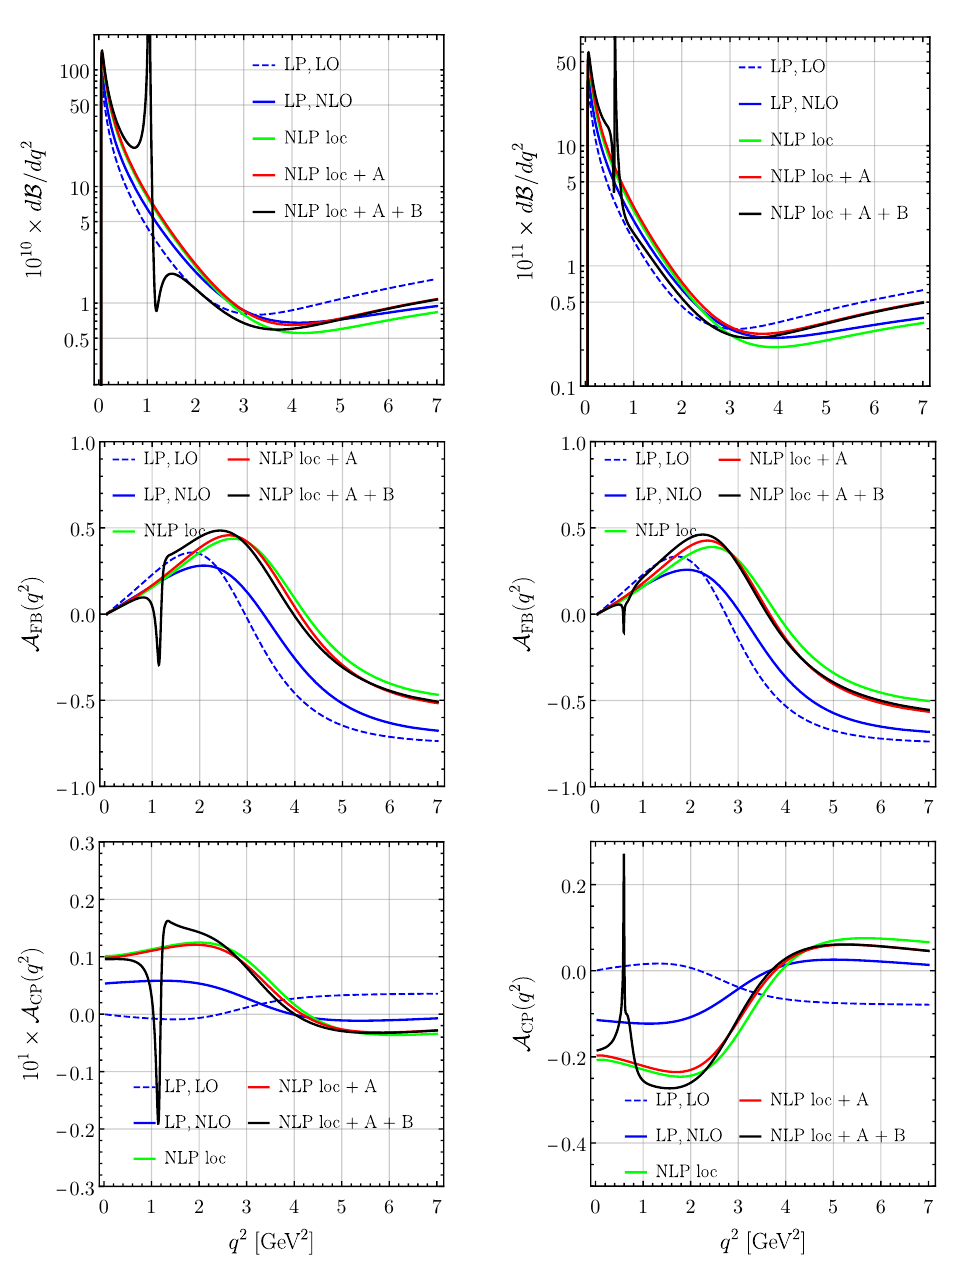
Figure 9 . The d B /dq 2 [upper], A FB ( q 2 ) [middle] and A CP ( q 2 ) [lower] distributions for B s → γµ ¯ µ [left] and B d → γµ ¯ µ [right] when adding successively various contributions: only LP [blue] at LO QCD [dashed] and NLO QCD [solid]; + local NLP corrections [green]; + nonlocal A -type [red]; + nonlocal B -type with lowest resonances [black] NLP corrections. The parameter r LP = 0 . 2